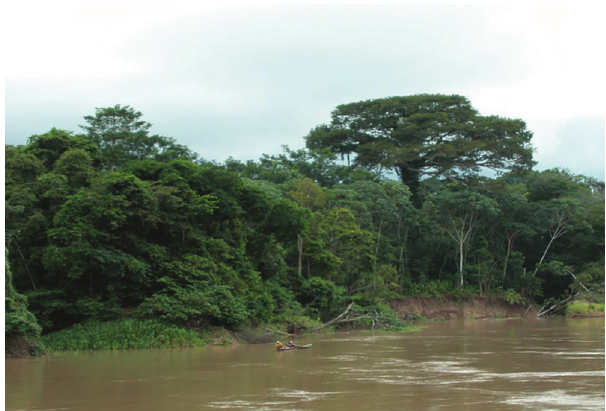
Fig. 13. Amazon River margin habitat near type locality of Sternarchella rex in Tefé, Brazil. Specimens were collected using 50 x 6 m or 50 x 8 m beach seine nets operated in the mid-channel and edges of whitewater floodplain channels of the río Solimões-Japurá confluence, and on beaches of the río Japurá near its confluence with the río Solimões (Amazon).